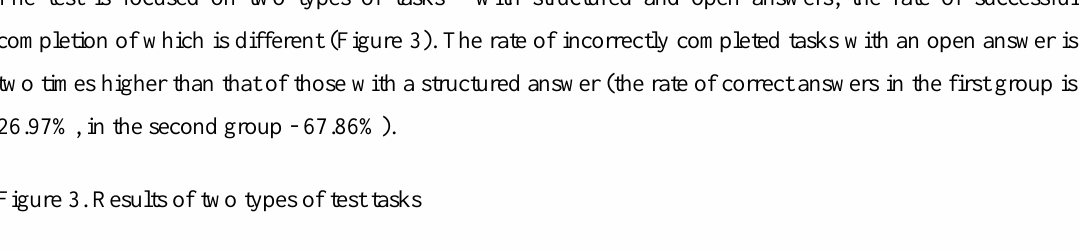
Figure 3. Results of two types of test